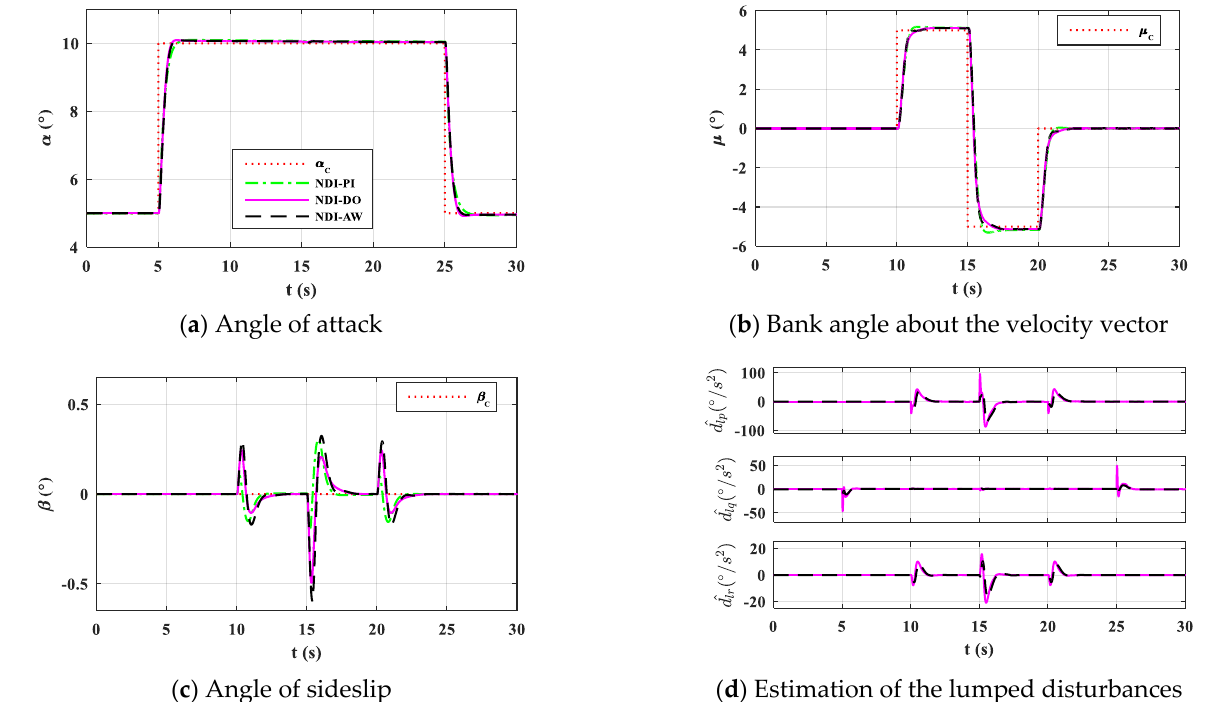
Figure 6. The nominal response of the tailless aircraft model controlled using NDI-proportional-integral elements (PI), nonlinear disturbance operator based NDI (NDI-DO), and NDI-anti-windup (AW).